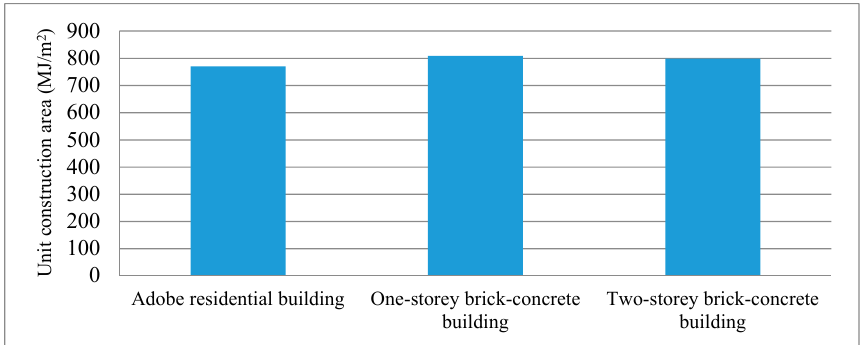
Figure 14. Total energy demand in the process of waste disposal.